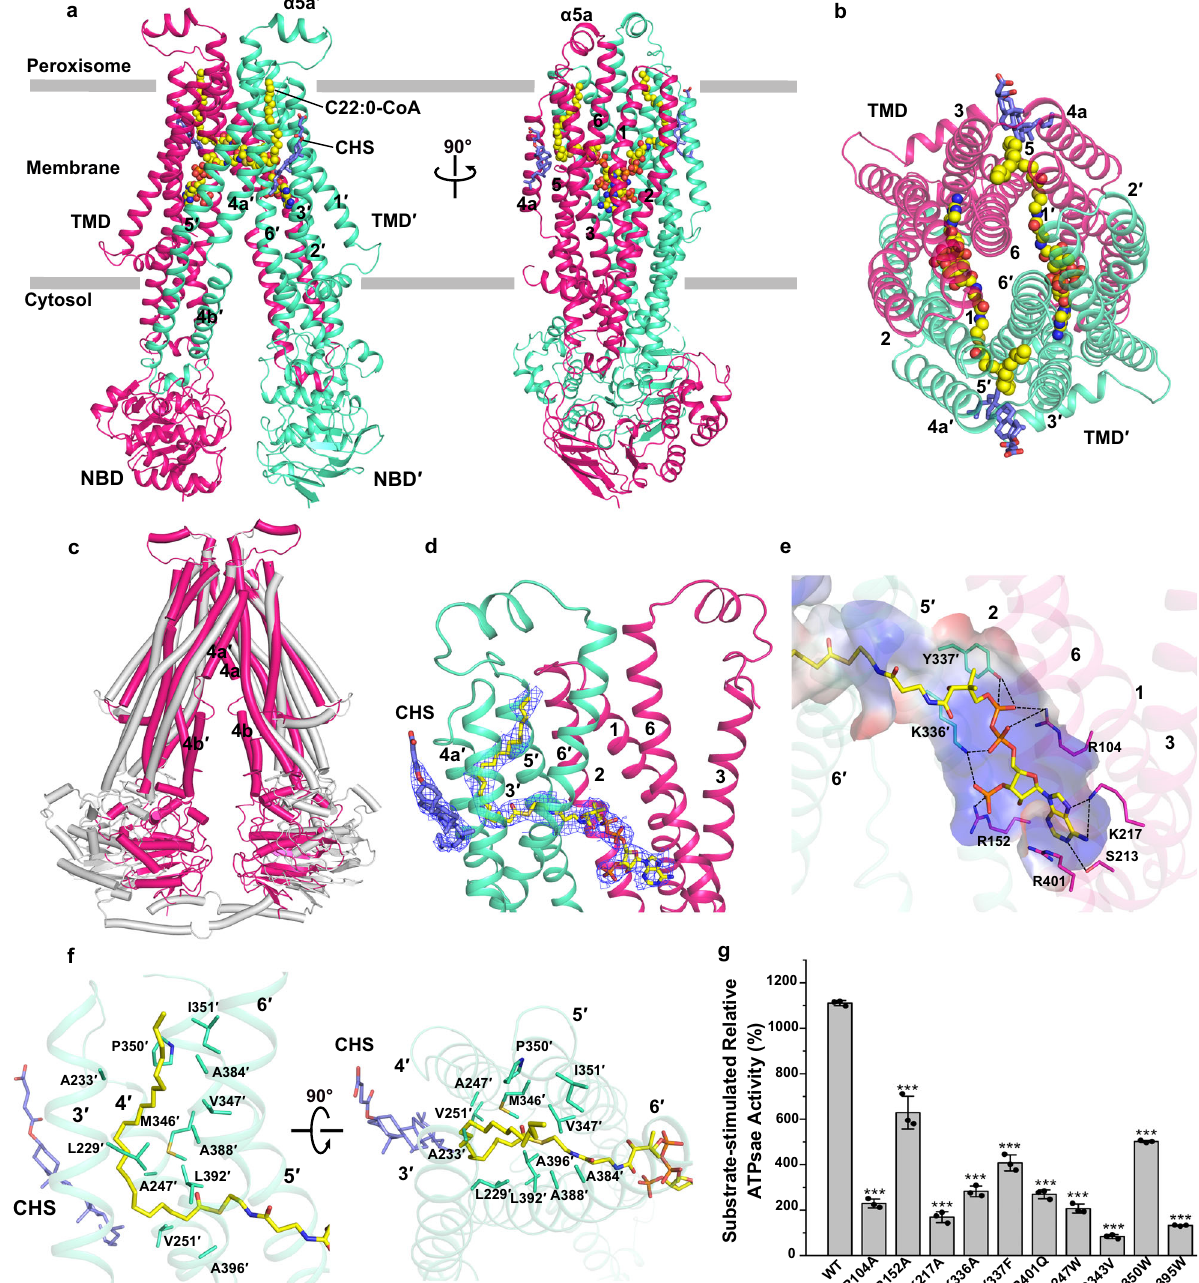
Fig. 3 Structure of substrate-bound ABCD1 and the substrate binding pocket. a Side and b Top view of the overall structure of C22:0-CoA-bound ABCD1. Two subunits of ABCD1 are colored in green and rose, respectively. The peroxisome membrane is indicated as the gray lines. The α -helices (termed α 5a/ 5a ’ ) in the peroxisome matrix is labeled. The two C22:0-CoA molecules are shown as yellow spheres, and the two cholesteryl hemisuccinate (CHS) molecules are shown as blue sticks. c Superposition of the apo-form (gray) against C22:0-CoA-bound ABCD1 (pink). TM4a/4a ′ and TM4b/4b ′ are labeled. d The C22:0-CoA molecule binding to TMDs. The density map of C22:0 and CHS, shown as blue mesh, are contoured at 5 σ . The CHS and C22:0- CoA are shown as blue and yellow sticks, respectively. e The binding pocket of the CoA portion of C22:0-CoA. The binding residues are shown as sticks, and hydrogen bonds ( ≤ 3.5 Å) and salt bridges ( ≤ 4.0 Å) are shown as black dotted lines. The electrostatic surface properties of the binding pocket are color-coded by electrostatic potential generated by PyMOL 2.5.2. f The binding pocket of fatty acyl chain of C22:0-CoA. The hydrophobic residues surrounding the fatty acyl chain within 4.5 Å are shown as sticks. The fatty acyl chain and CHS are shown as blue and yellow sticks, respectively. g Relative ATPase activities of chABCD1 and mutants in detergent of LMNG + CHS and 2 mM ATP upon addition of C22:0-CoA. The relative activity represents the substrate-stimulated activity of chABCD1 or its mutant that harboring a single mutation of residues at the substrate-binding pocket. Each data point is the average of three independent experiments ( n = 3), and error bars represent the means ± SD. One-way analysis of variance (One-way ANOVA) is used for the comparison of statistical signi fi cance of mutants and wild-type. The p value of R104A, R152A, K217A, K336A, Y337F, R401Q, A247W, G343V, P350W and A395W is 0.00019, 0.00062, 0.00076, 0.00092, 0.00053, 0.00063, 0.00014, 0.000178, 0.00031 and 0.00012. The p values of <0.05, 0.01, and 0.001 are indicated with *, ** and ***. Source data are provided as a Source Data fi